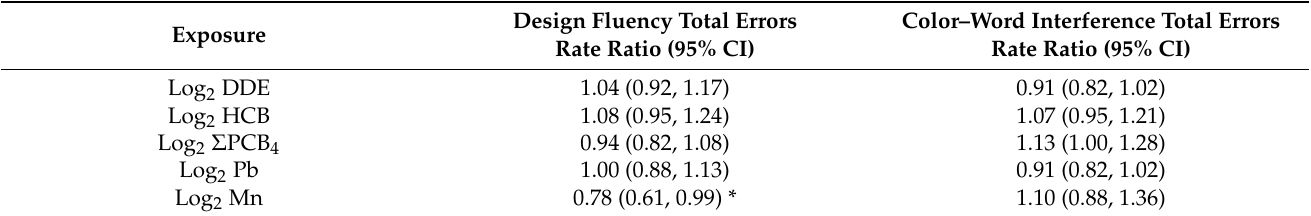
Table 5. Complete-case results of negative binomial regression analyses (rate ratio and 95% CI) 1 assessing the relation of prenatal exposure to a five-chemical mixture with Delis–Kaplan Executive Function System (D-KEFS) inhibition error raw scores among adolescents in the main analysis group 2 .